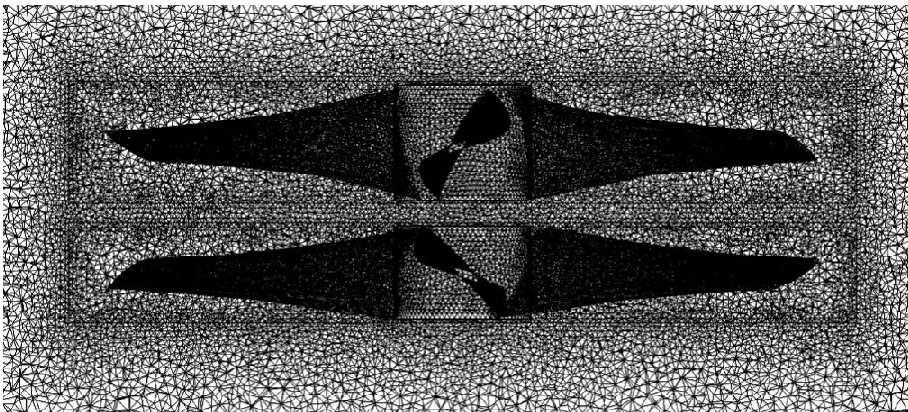
Figure 4. Computational mesh of the coaxial propellers.